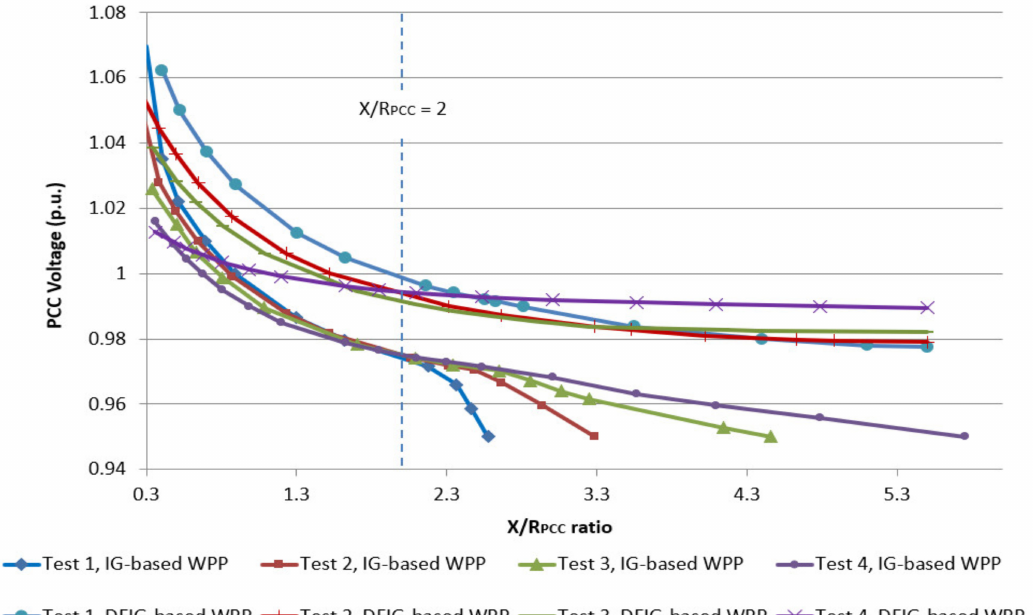
Figure 3. V PCC -X / R PCC characteristic for each test system for both the Induction Generator (IG) and the Double Fed Induction Generator